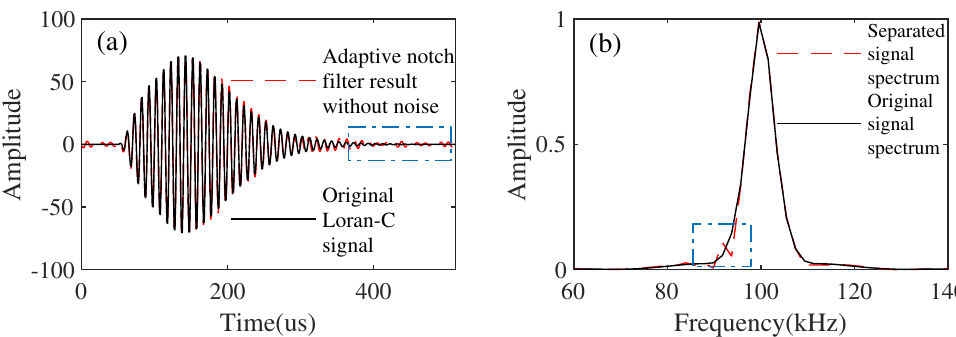
Figure 10. The results of CWI suppression using an adaptive notch filter without noise added. ( a ) The results of adaptive notch filter without noise. ( b ) Comparison of the separated signal spectrum and the original signal spectrum.